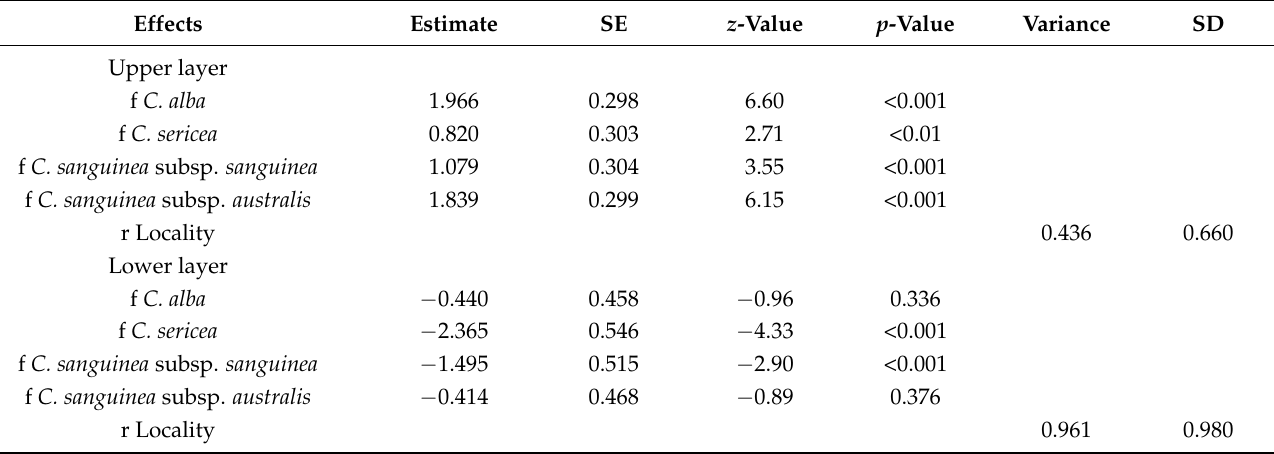
Table 4. GLMM results for the intact seed density in the upper (0–5 cm) and lower (5–10 cm) soil layers. Taxa were considered as a fixed effect (f), whereas locality was considered as a random effect (r). SE—standard error; SD—standard deviation.